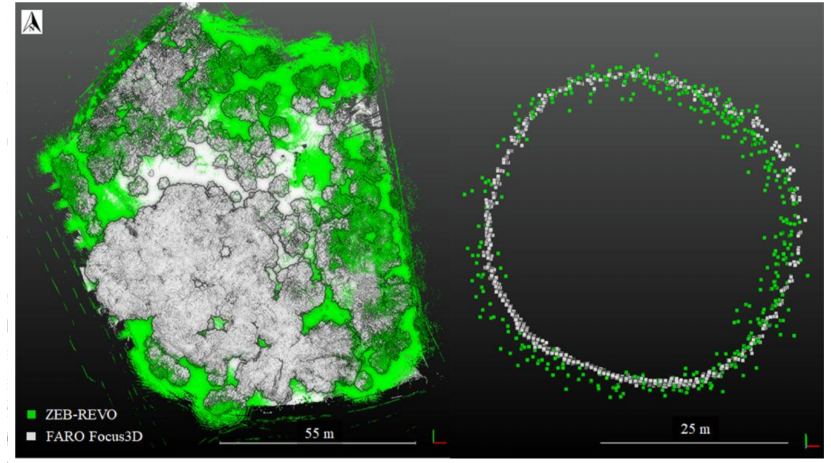
Figure 13. Plant view of the final forest 3D models in the same coordinate system for test site A ( left ) and a section of a pine trunk ( right